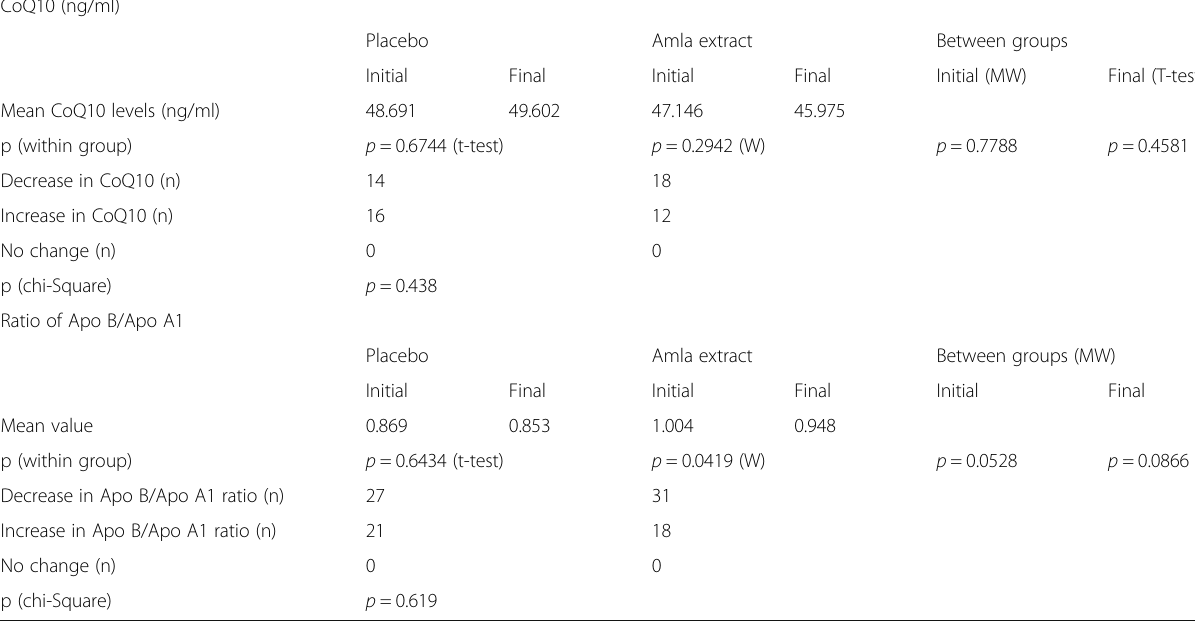
Table 2 Table with p values within the group (amla extract/placebo) and between groups (Continued) CoQ10